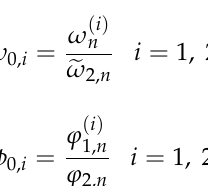
Figure 2. Mode shapes of the first 8 modes for the fixed-fixed double beam system.